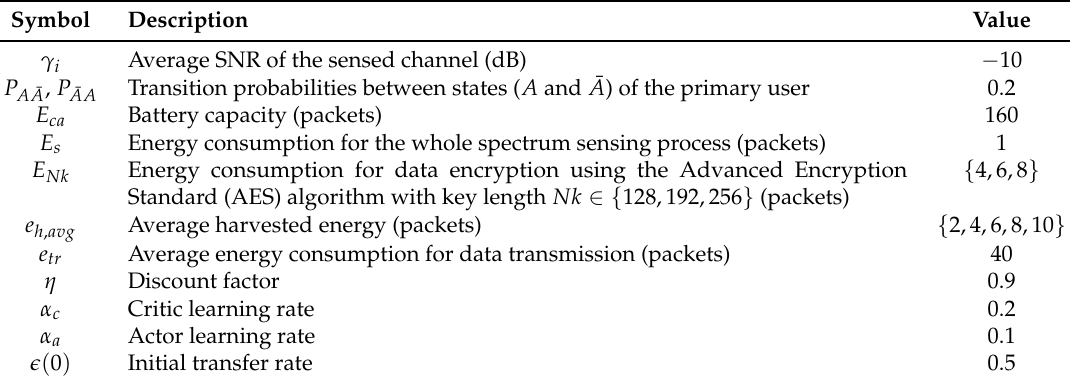
Table 3. Simulation parameters for transfer learning actor–critic (TLAC) [20].